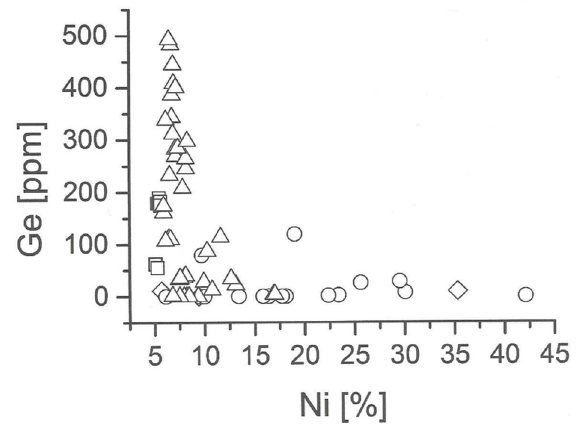
Figure 7. Linear plot Ge against Ni for iron meteorites without plessitic octahedrite Butler (data from Table 2). r = 0.5 Δ octahedrites, o hexahedites, ¡ ataxites, ◊ anomalous.